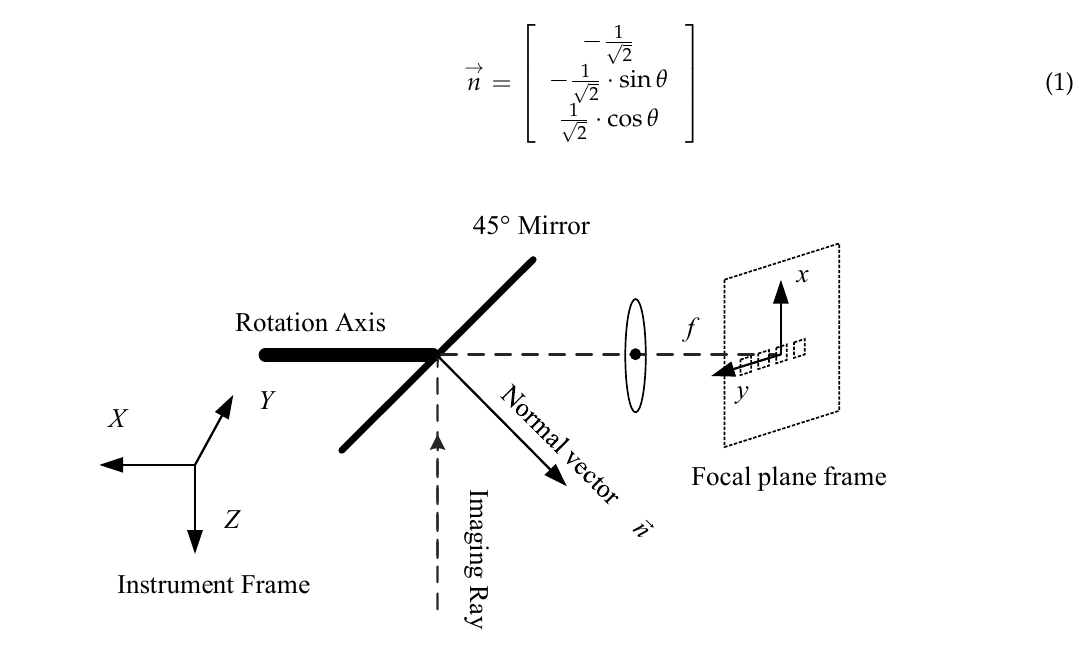
Figure 2. Sketch of VIRR imaging system. → n . The reflection matrix R b could be determined by the normal vector For the sake of simplicity, a focal plane frame is perpendicular to the reflected optical axis, with the x -axis parallel to the along-track direction and y -axis in the along-scan direction, and the origin is the point at which the optical axis meets the FPA. Using the reflection matrix, another detector ( x 0 , y 0 ) in the focal plane frame can be transformed into a line-of-sight (LoS) in the body frame. where 0(cid:3433) 𝑹 (cid:3033)(cid:3040) = (cid:3429) −1 0 is the transformation matrix from the focal plane to the mirror frame and (cid:4666)𝑥 (cid:2868) ,𝑦 (cid:2868) (cid:4667) are the positions of the detectors in the focal plane. For the reference band, x 0 = 0 and y 0 = 0. The ray in the body frame can be expressed as (cid:4670)0 𝑓 ⋅ 𝑠𝑖𝑛 𝜃 −𝑓 ⋅ 𝑐𝑜𝑠 𝜃(cid:4671) (cid:3021) . The detector from the optical axis, with inner orientation parameters 𝑥 (cid:2868) ,𝑦 (cid:2868) ,𝑓 , cap- where tures the point (cid:4670)𝑋 (cid:3029) 𝑌 (cid:3029) 𝑍 (cid:3029) (cid:4671) (cid:3021) at scan angle θ , as shown in Equation (3). The differences in ephemeris and attitudes were ignored because of the short time intervals. To capture